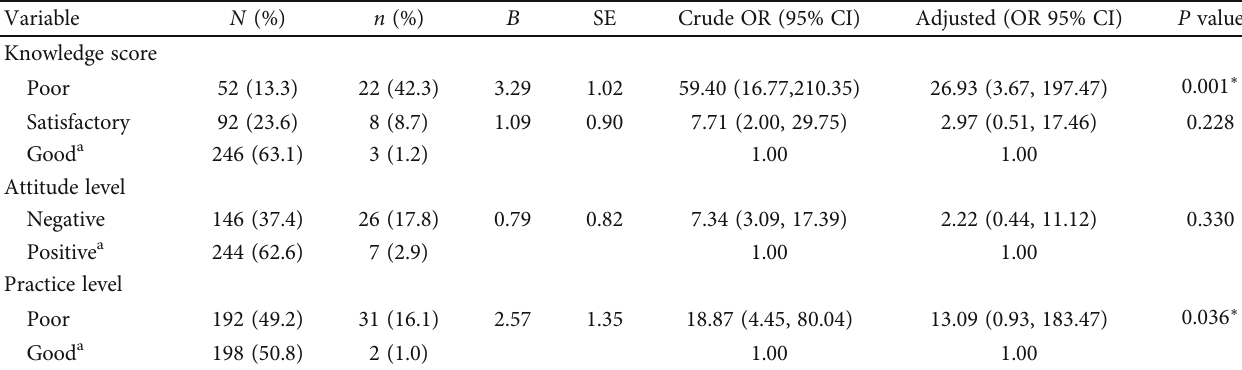
Table 7: Multivariate logistic regression analysis of malaria prevalence with